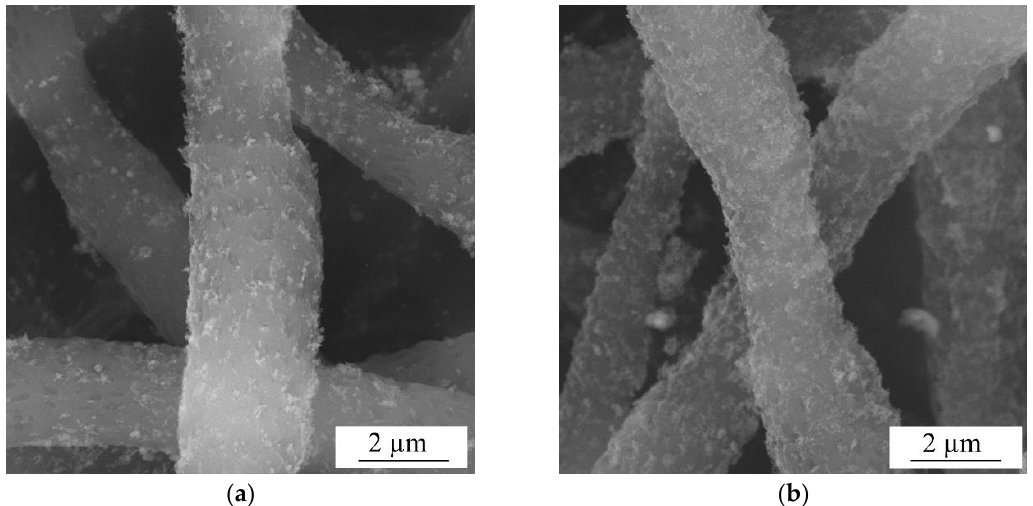
Figure 4. SEM images of model wound dressing tissues based on PLLA scaffold loaded with ZnO_water ( a ) and ZnO_air ( b ) NPs.